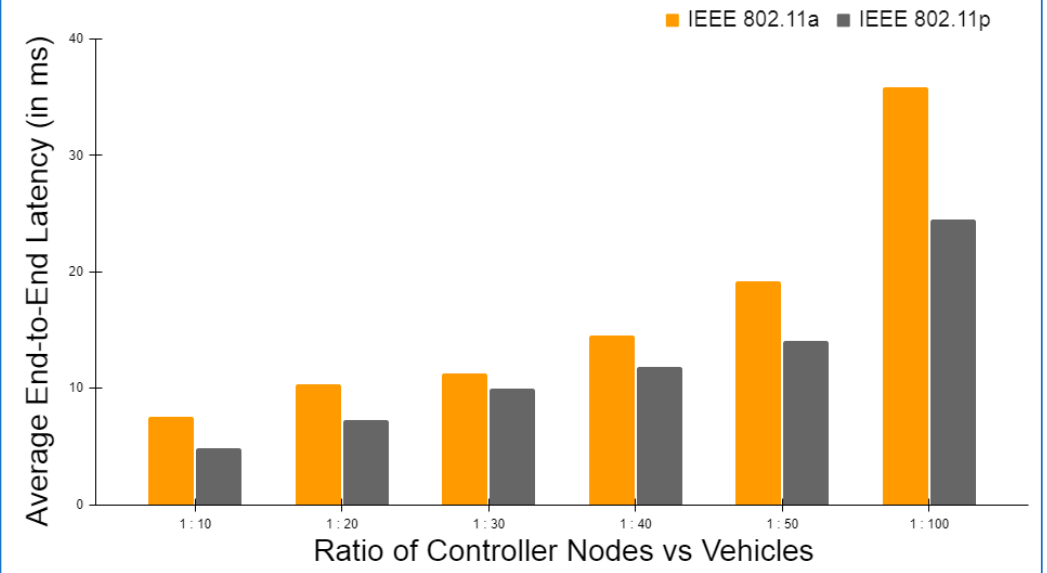
Figure 9. End-to-End Latency Time in the proposed framework for IEEE 802.11a vs. IEEE802.11p.